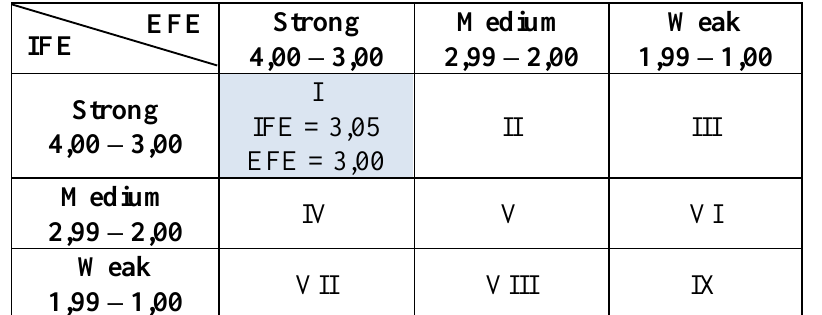
Table 4. Internal-External Matrix (IE)